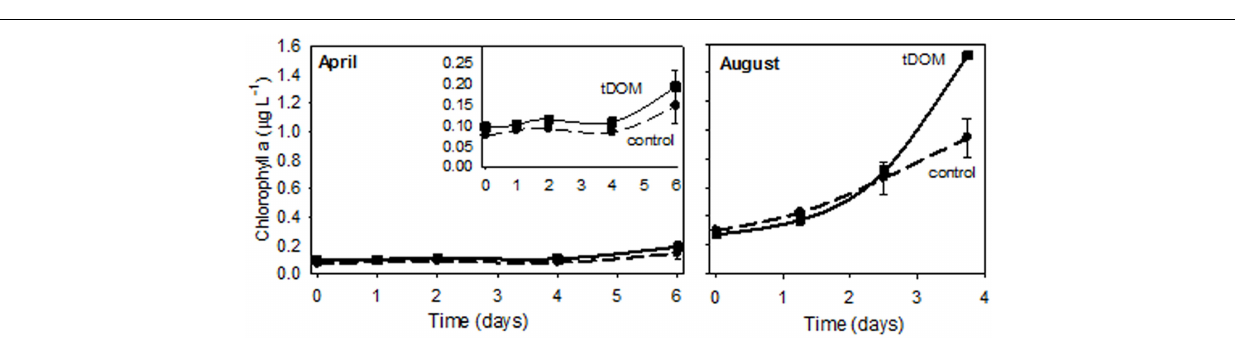
FIGURE 4 | Chlorophyll a response to tDOM additions. Change in Chl a concentrations for the ice-covered (April) and open-water (August) bioassays. The inset in the April figure zooms in on the lower range of the Chl a scale. Control treatments are indicated by a dashed line and treatments with additions of tDOM are indicated using a solid